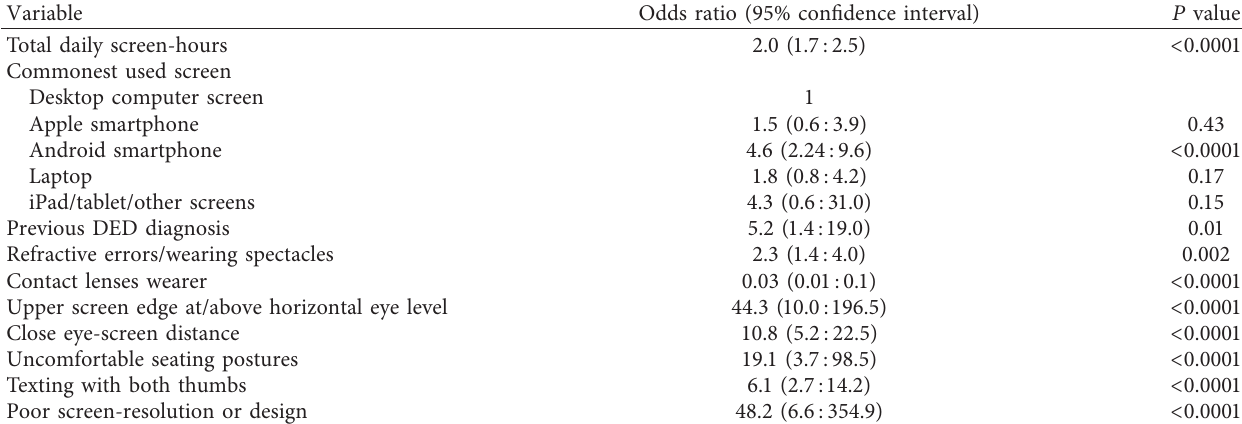
Table 4: Final multivariate logistic regression analysis model of factors affecting the occurrence of computer vision syndrome.